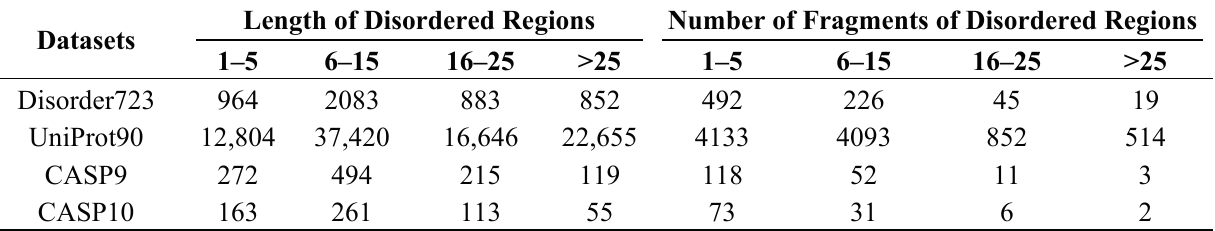
Table 1. Overall properties of the non-terminal disordered regions with different lengths on the four datasets used in this